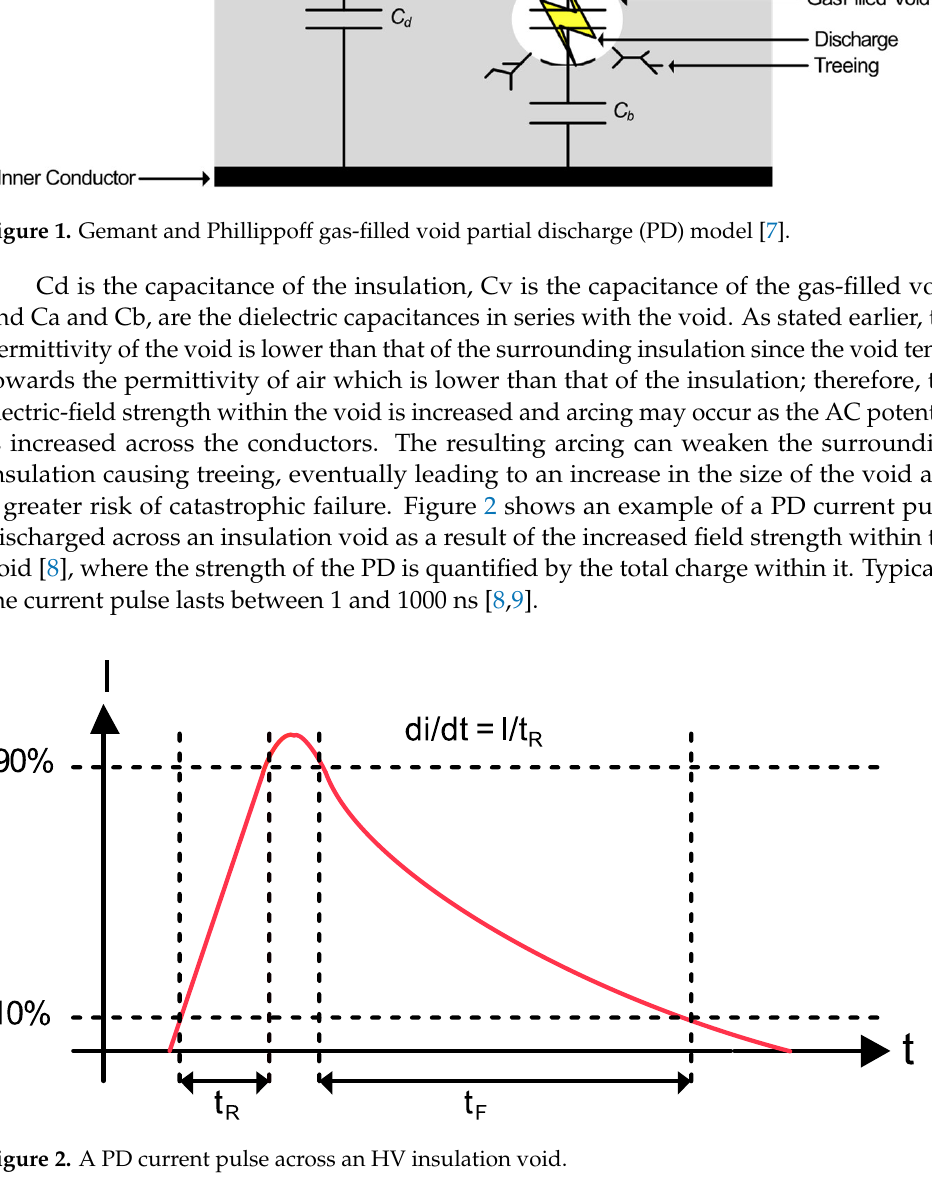
Figure 1. Gemant and Phillippoff gas-filled void partial discharge (PD) model [7].